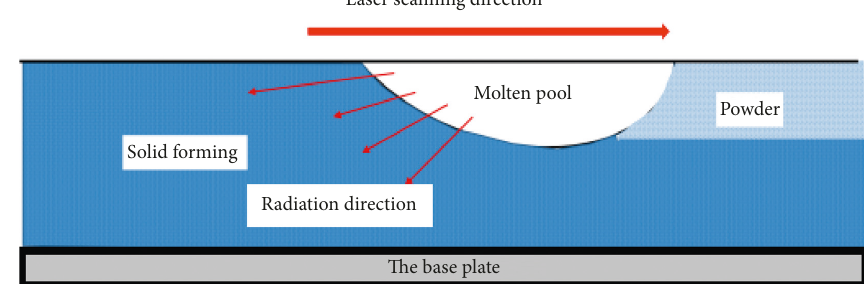
Figure 5: Scatter heat diagram in the SLM process.